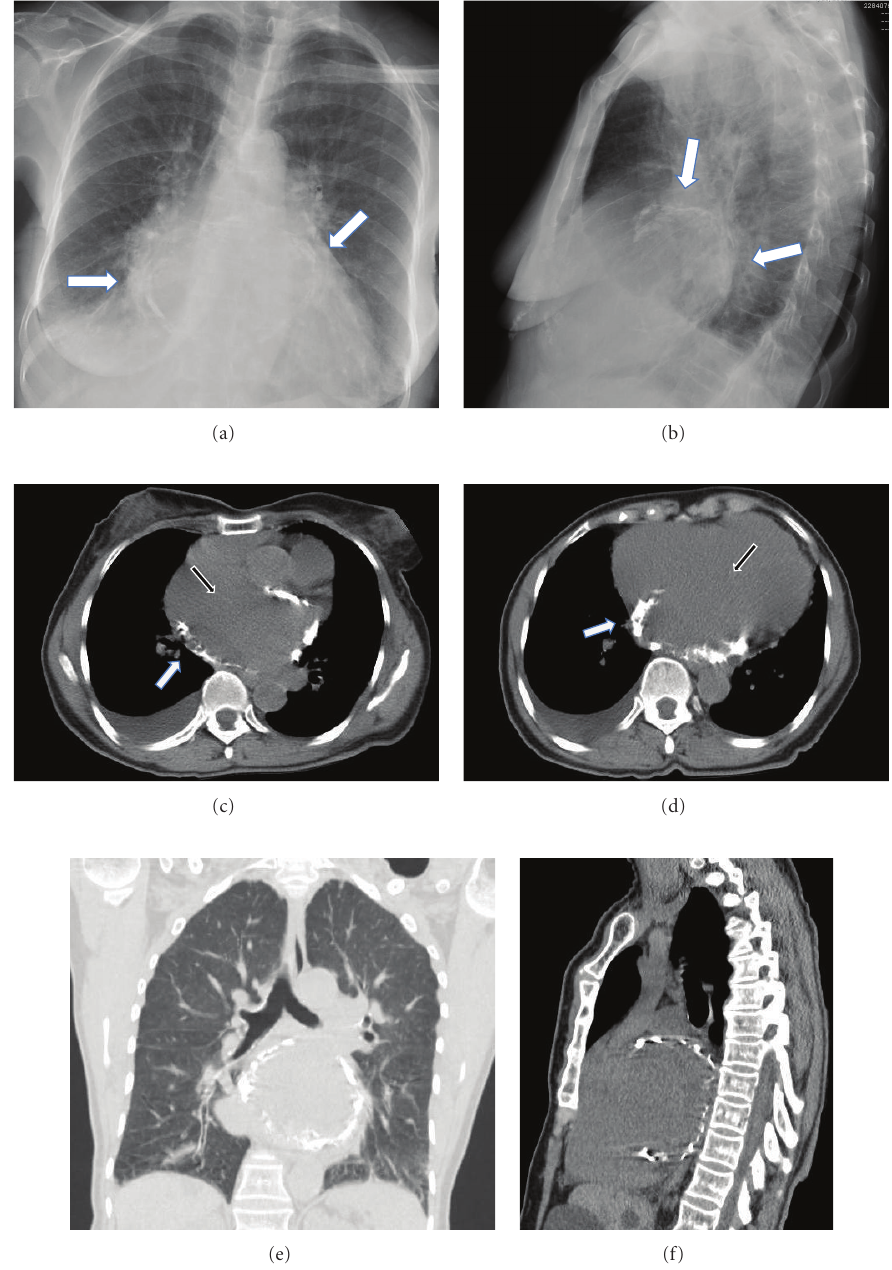
Figure 1: A 71-year-old woman with known mitral stenosis and atrial fibrillation underwent routine preoperative screening for cataract surgery. The chest X-ray showed curvilinear dense calcifications on both the frontal ((a), arrows) and lateral ((b), arrows) views. A follow up noncontrast CT of the chest better localized these calcifications on axial images ((c), (d), white arrows), coronal image (e) and sagittal image (f), as being in the wall of the left atrium. The interatrial septum ((c), black thin arrow) and mitral valve annulus ((d), thin black arrow) were not calcified. The coronal (e) and sagittal (f) images show a pattern of calcification very similar to the one seen on the frontal (a) and lateral (b) chest X-rays. Incidental right pleural e ff usion and liver cysts were also shown.